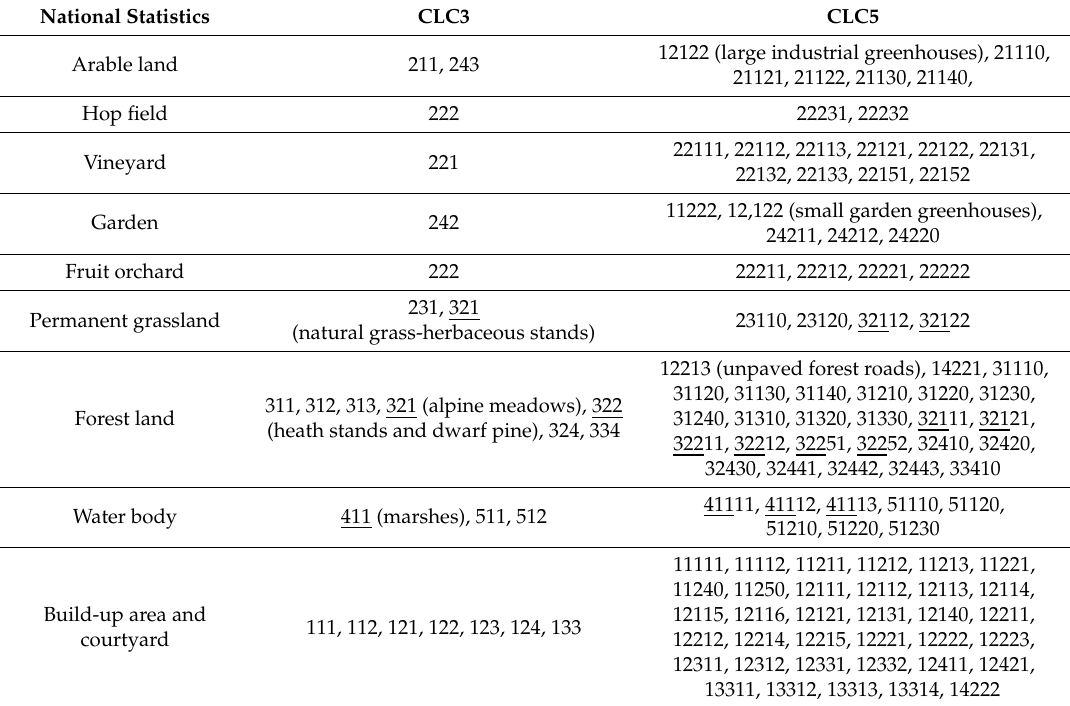
Table 3. Classification of CLC classes into 10 categories of national statistics. Underlined codes of CLC3 classes are on the CLC5 level divided into 2 categories of national